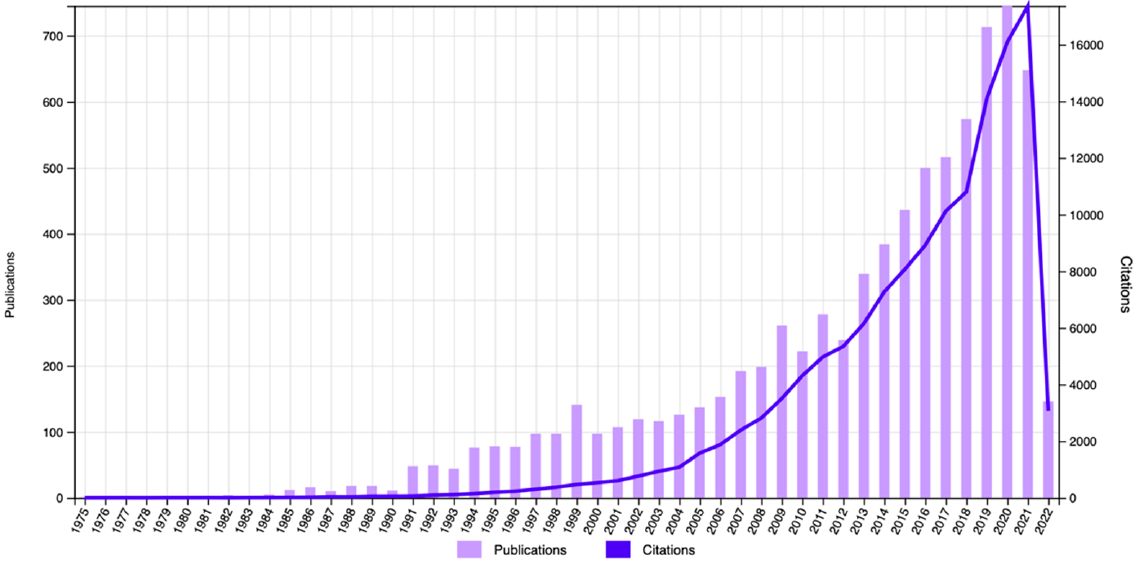
Figure 1. Number of publications and citations mentioning the term “gender” in the Web of Science categories of Communication or Film, Radio, Television.